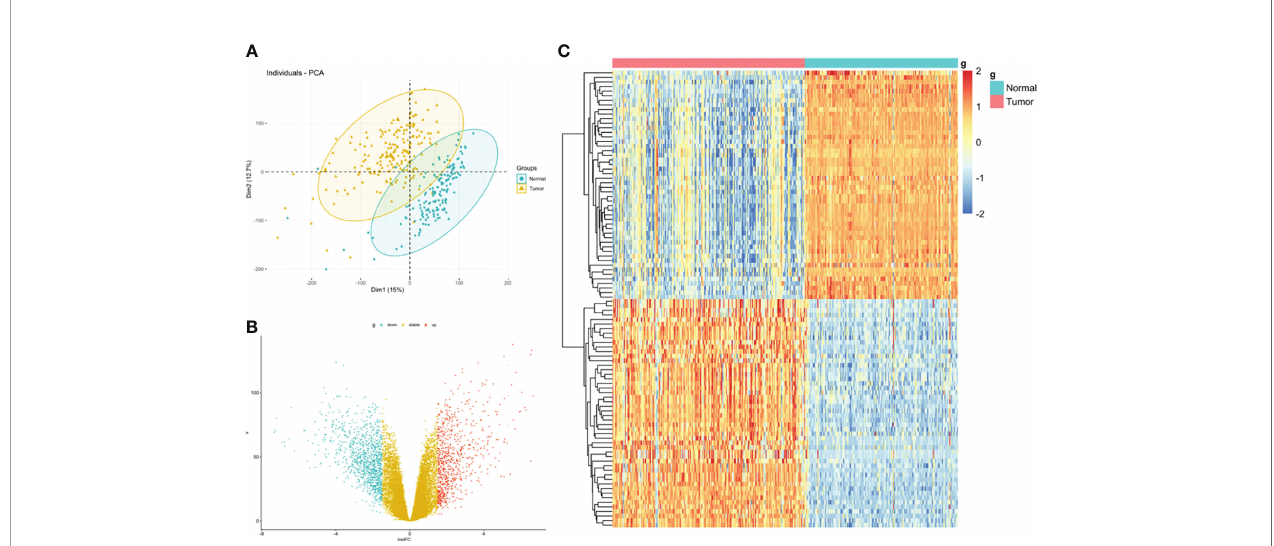
FIGURE 2 | Identi fi cation of DEGs between rectal carcinoma tissue and mucosa control tissue. (A) Principal component analysis (PCA) of expression level of rectal cancer and normal tissue. (B) Volcano plot and (C) hot map illustrating differentially expressed genes (DEGs) between rectal carcinoma tissue and mucosa control